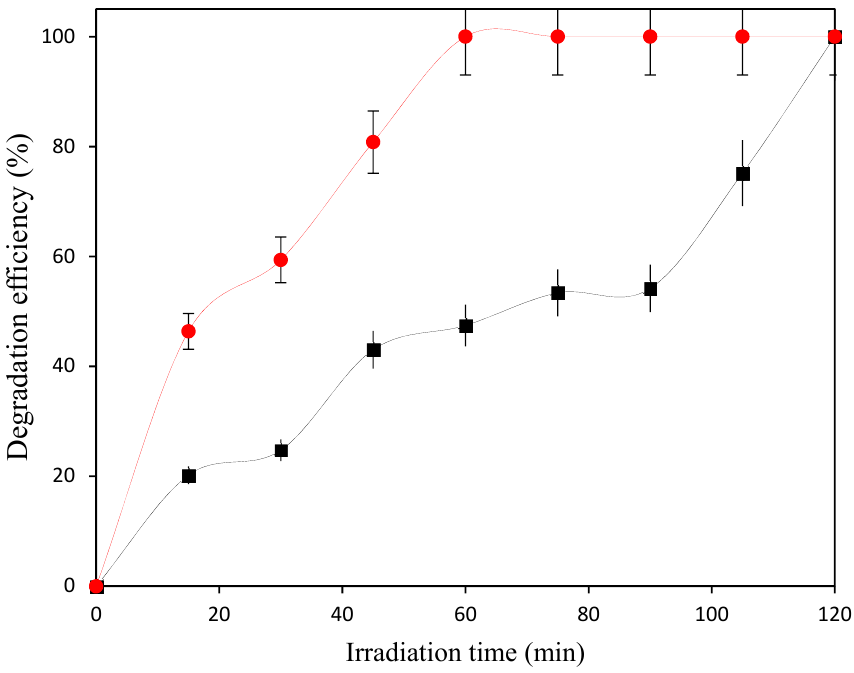
Figure 8. 4-CP degradation efficiency measured using the photo-Fenton experiments at initial 4-CP concentration: 20 mg/L, pH: 3, 0.05 g/L catalyst loading and 2 ml of H 2 O 2.